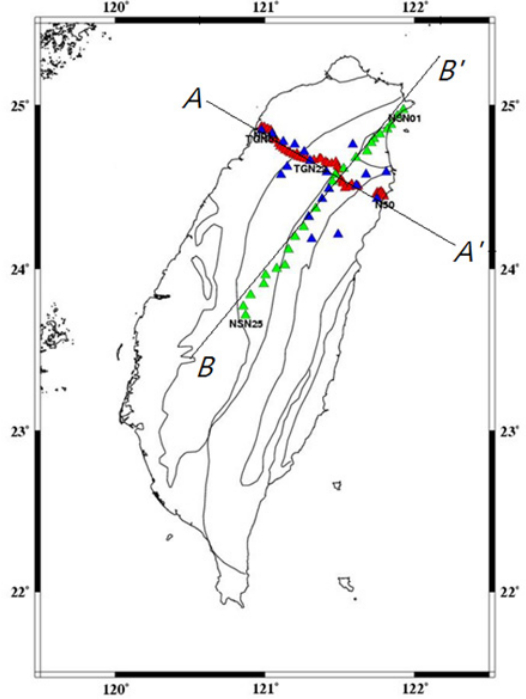
Figure 2. The positions of two orthogonal linear dense arrays deployed in north Taiwan in east–west (A-A’ line) and south–north (B-B ′ line) directions. The blue triangles represent 19 broadband seismic stations installed from May 2007 to July 2008. The green triangles indicate 25 broadband stations installed from February 2008 to June 2009, and the red triangles are 45 short-period stations installed from March 2008 to June 2008.